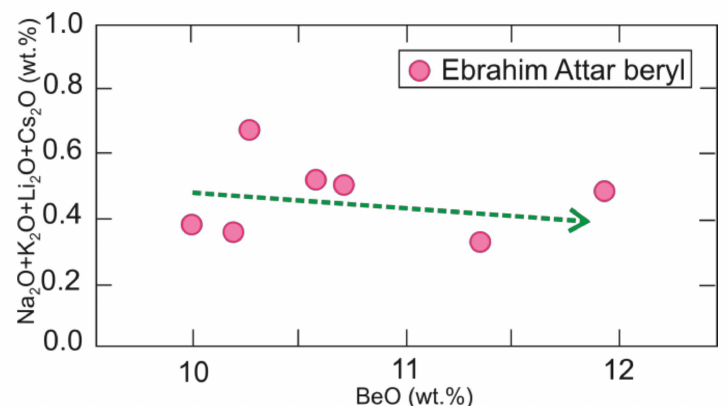
Figure 9. The plot of total alkali element content (Na 2 O + K 2 O + Li 2 O + Cs 2 O) vs. BeO of the Ebrahim-Attar beryl shows a weak negative correlation.